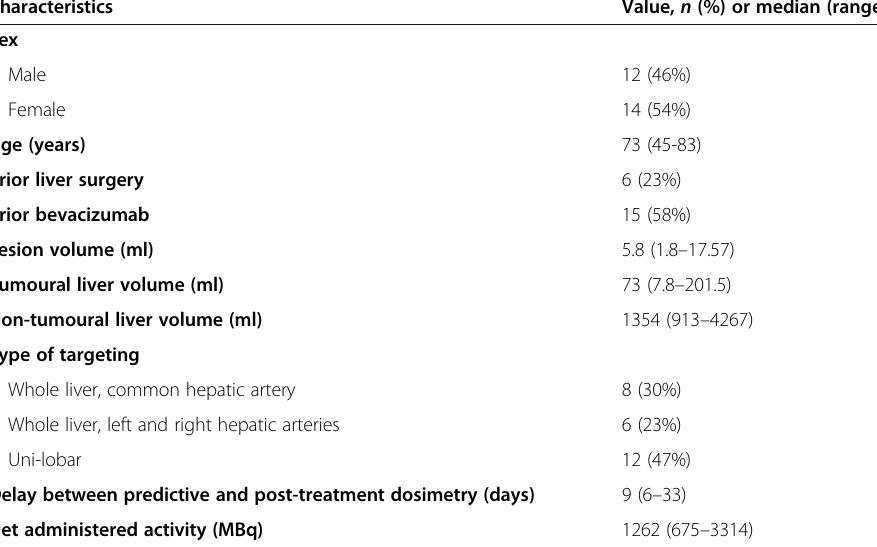
Table 1 Baseline characteristics of patients